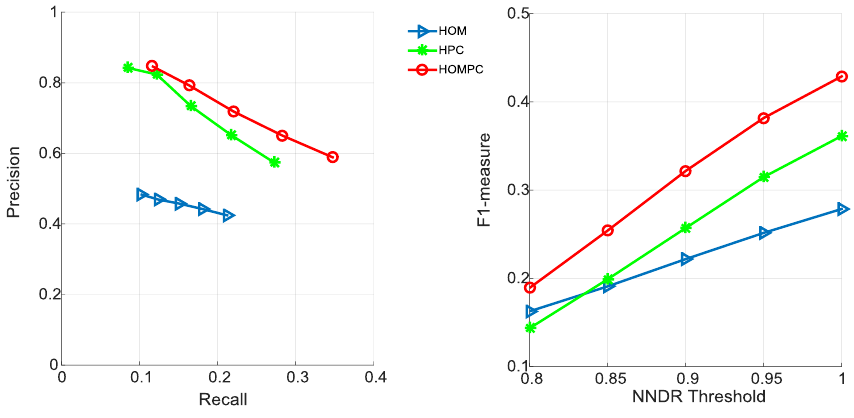
Figure 12. The average PR curves and F1-measure curves of HOMPC, HPC, and HOM.